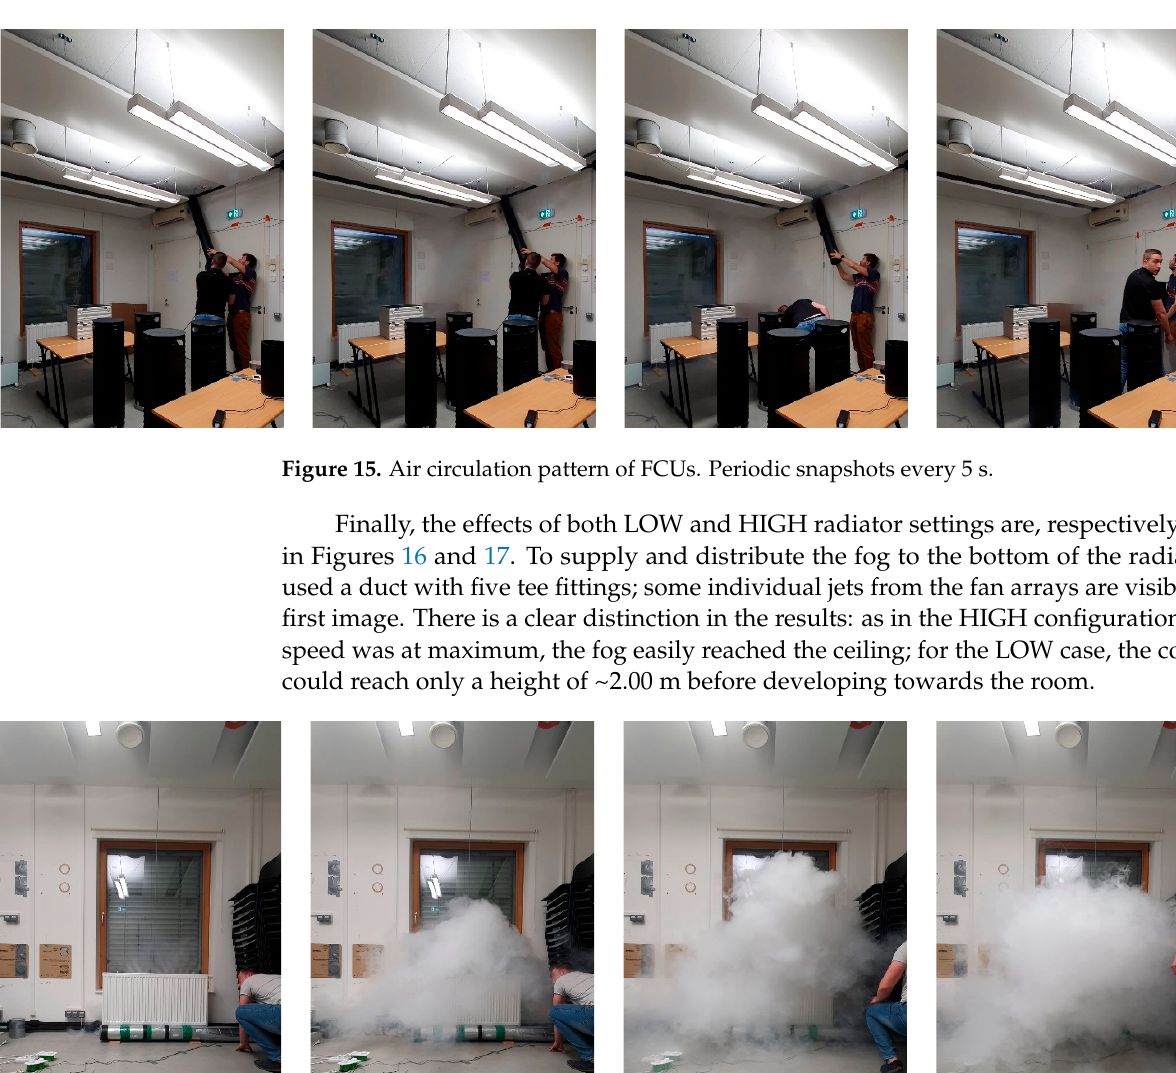
Figure 14. Air circulation pattern of ceiling panels HIGH. Periodic snapshots every 5 s.